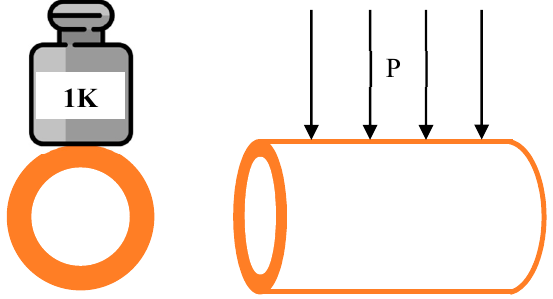
Figure 4. Testing method for the compression capability of a single straw.